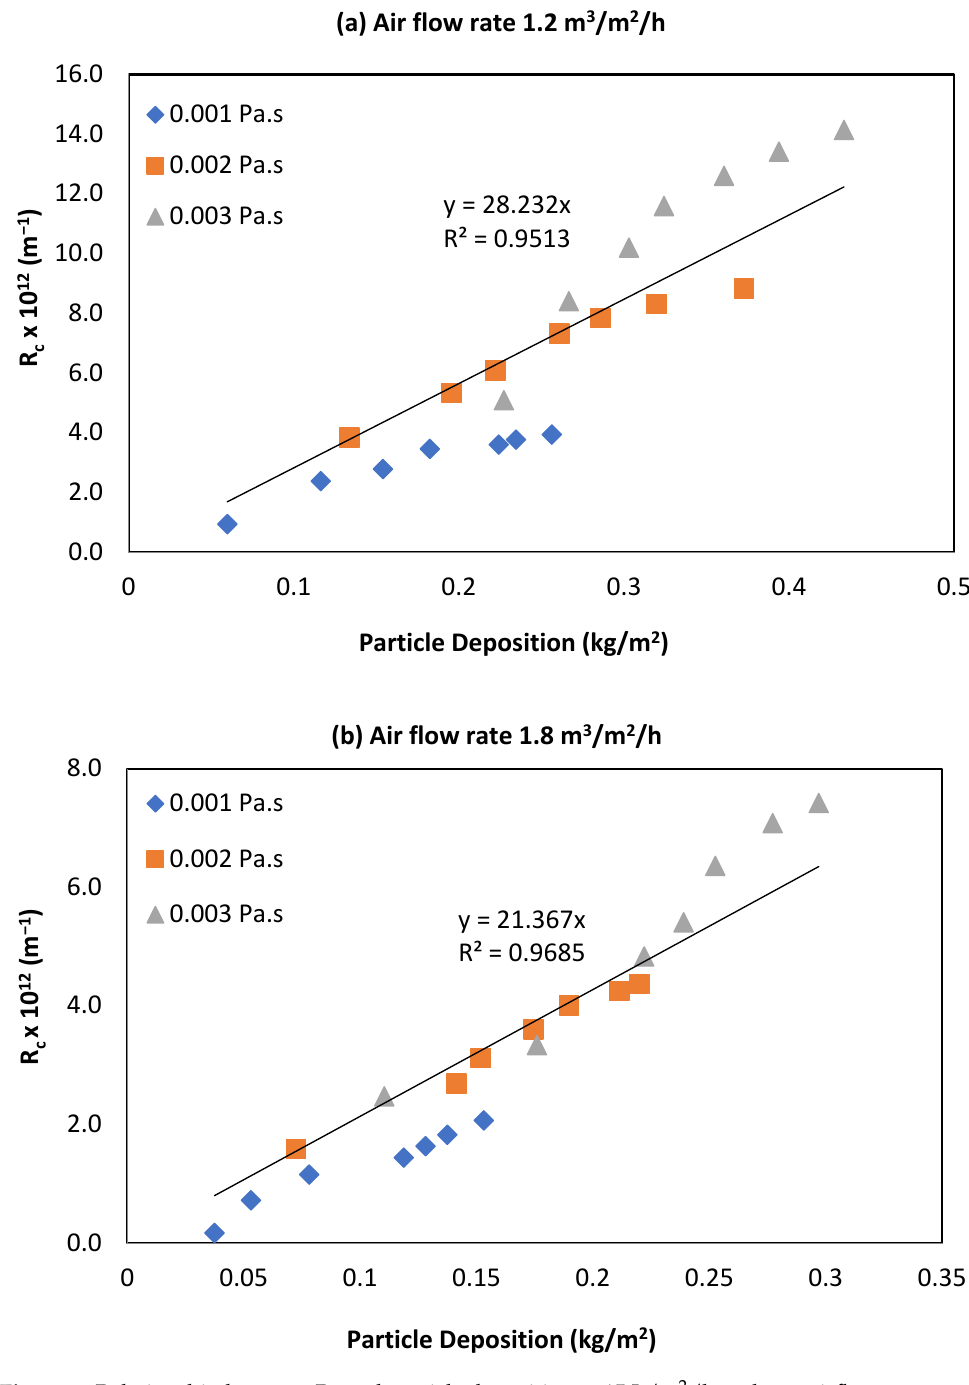
viscosities and airflow rates for a permeate flux of 10 and 15 L/m 2 /h are shown in the Supplementary Material (Figures S3 and